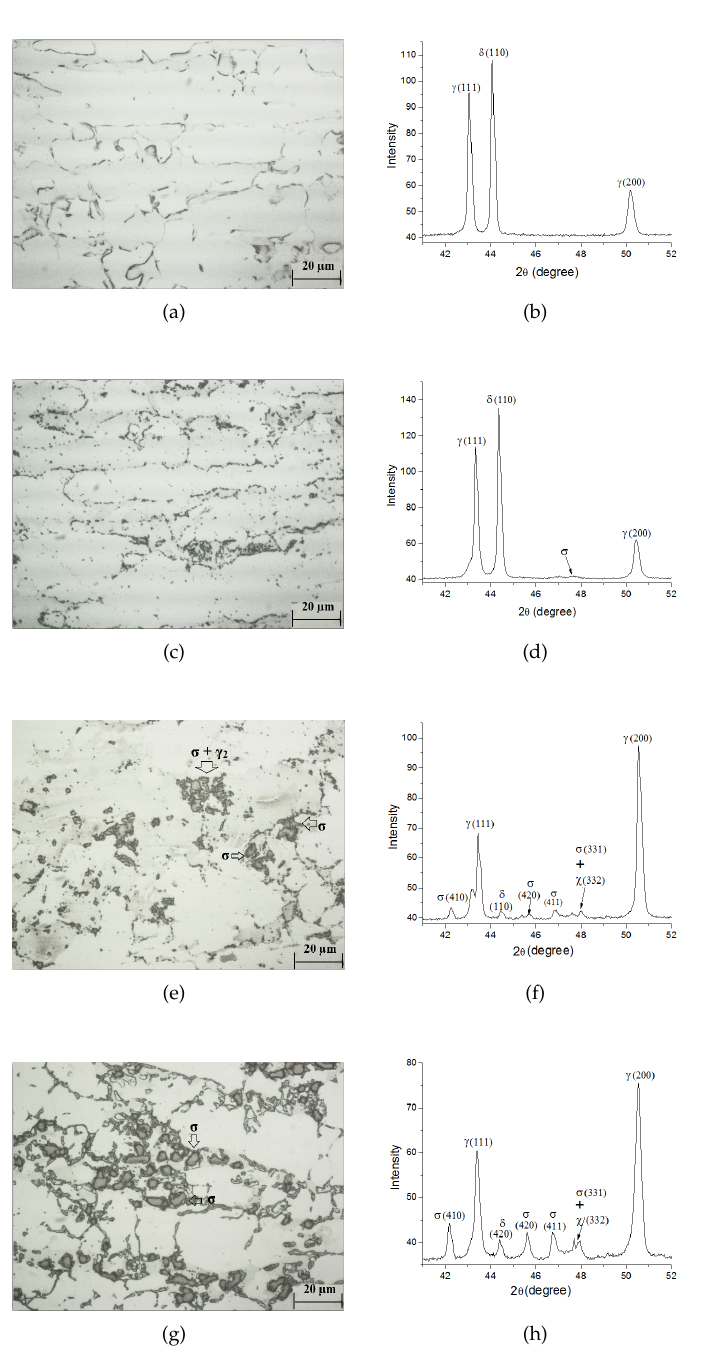
Figure 3. Microstructures of the studied samples with different contents of sigma phase and related X-ray diffractions, respectively: ( a ) 2.24%; ( b ) 2.24% (X-ray); ( c ) 2.84%; ( d ) 2.84% (X-ray); ( e ) 7.5%; ( f ) 7.5% (X-ray); ( g ) 18%; ( h ) 18% (X-ray). ( σ - sigma phase, γ 2 - austenite formed together with sigma